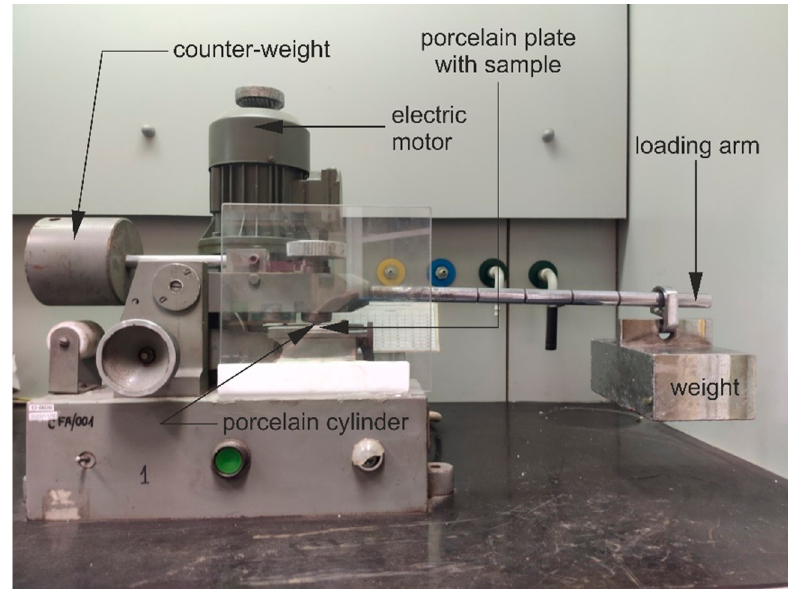
Figure 9. Peters friction